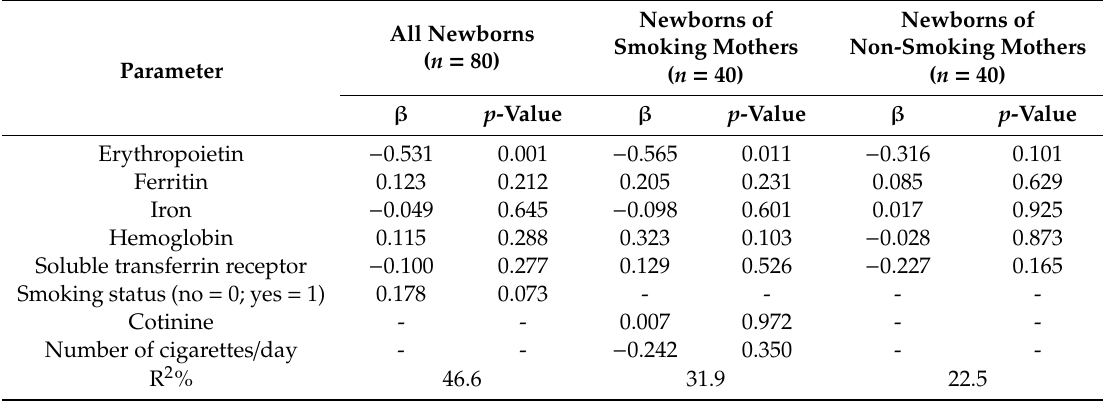
Table 4. Multivariate regression of hepcidin with iron status parameters and markers for